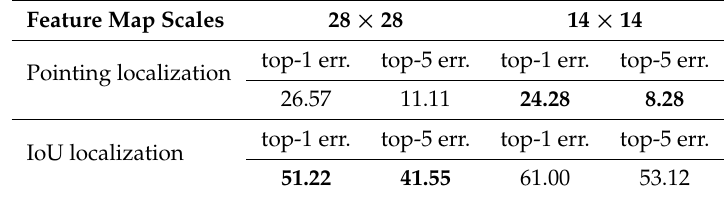
Table 6. Comparison of feature maps with different scales on the CUB-200-2011 dataset.